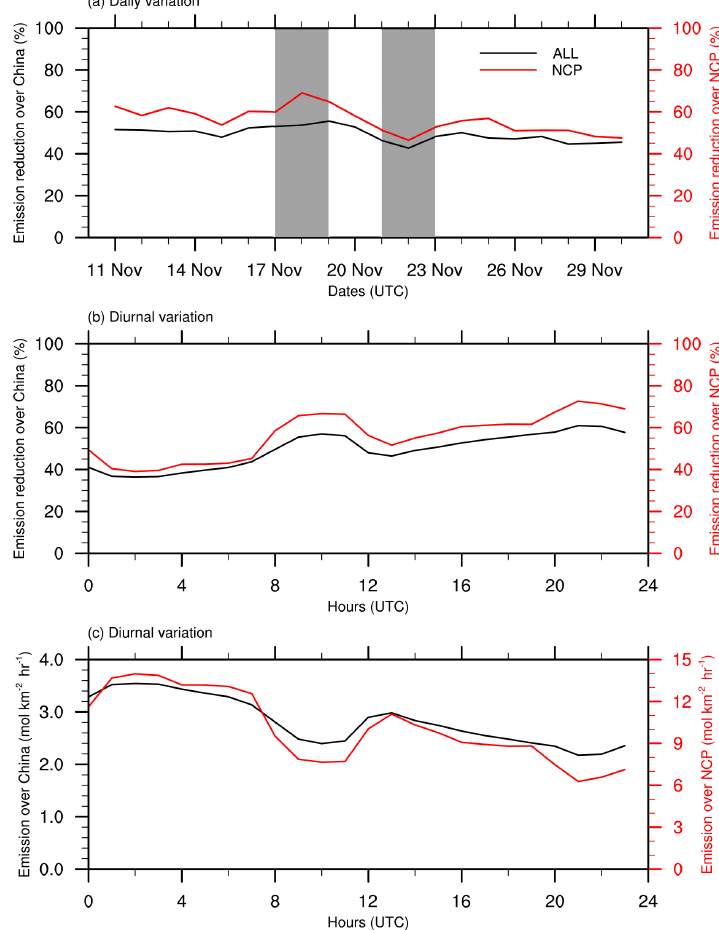
Figure 11. Daily (a) and diurnal (b) variations of the SO 2 emission reductions over China and the NCP subregion based on the inverted emissions. Diurnal variations of the inverted SO 2 emissions over China and the NCP subregion (c) .